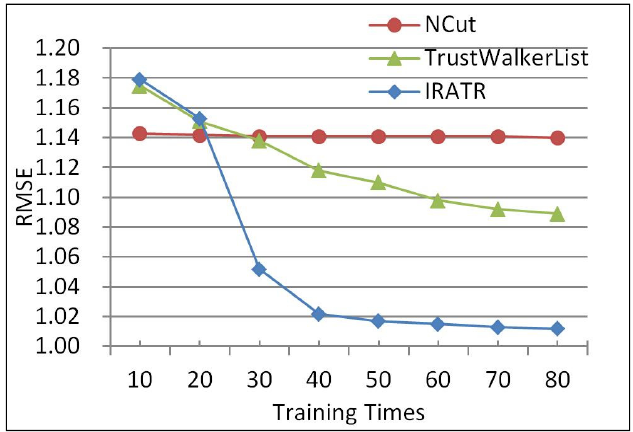
Figure 2. Comparison on all users.